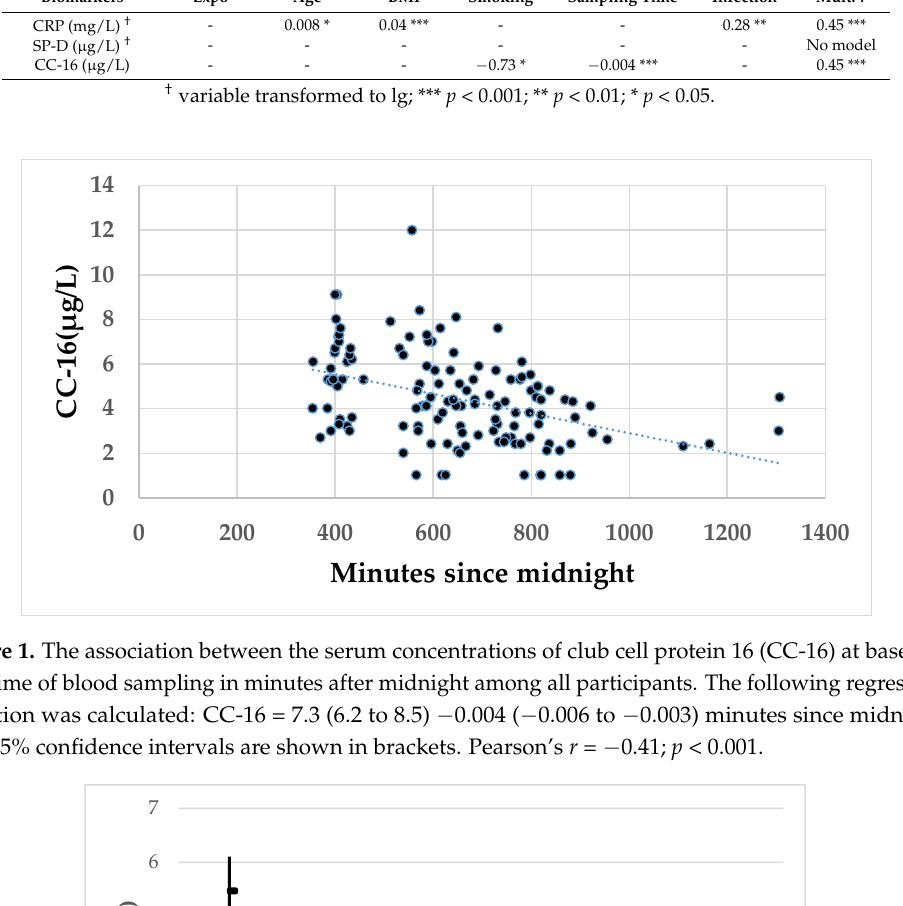
Figure 3. The mean (and 95% CI) concentrations of CC-16 in non-smokers/non-snuffers, non- smokers/snuffers and smokers/non-snuffers according to serum nicotine (S-Nico) concentrations that were higher or lower than the methods ’ detection limit. The estimates are adjusted for time of sampling. The p -values refer to differences between the group of non-smokers/non-snuffers and the three other groups, respectively. Table 4. Statistically significant results from multiple linear regression analysis (backward procedure). Dependent variables were the concentrations of C-reactive protein (CRP), club cell protein 16 (CC-16) and surfactant protein D (SP-D) at baseline. Independent variables were exposure category (Expo) (0/1), age (years), infection (0/1), body mass index (BMI) (kg/m 2 ), sampling time (minutes since midnight) and current tobacco smoking (0/1). Beta-coefficients and corresponding p - values are presented.